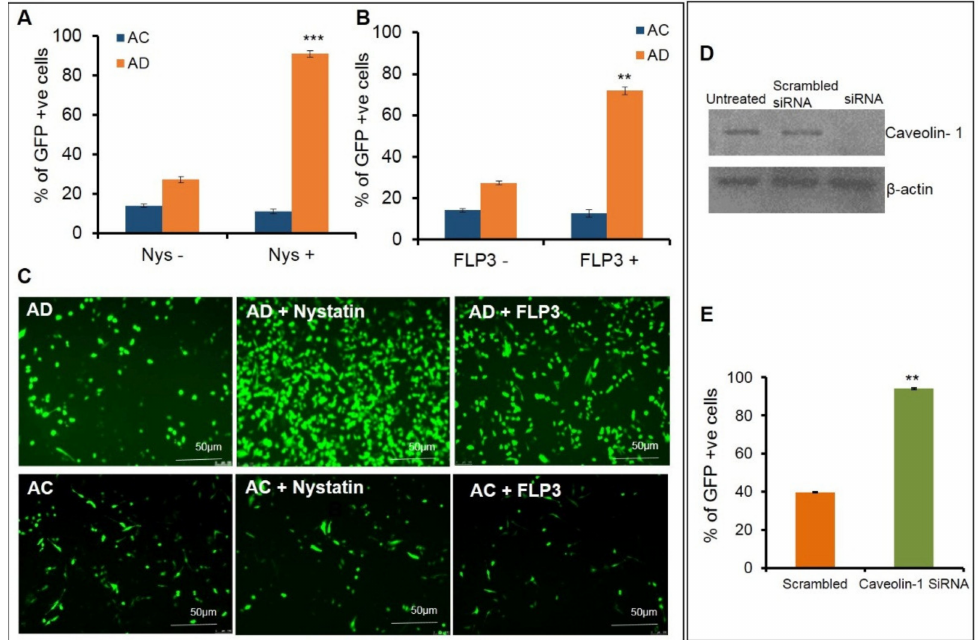
Figure 2. Effect of Caveolae Inhibitors/Blockers on Transfection activity. % of GFP-positive cells assessed by Flow cytometric analysis in nystatin pretreated SK-HEP1 cells ( A ) and filipin III pretreated SK-HEP1 cells ( B ). Representative fluorescence micrographic images for cells transfected using AD ( C upper panel) and AC ( C lower panel). Knockdown of Cav-1 with siRNA and transfection activity ( D , E ). Caveolin-1 knockdown efficiency demonstrated with Western blot ( D ).